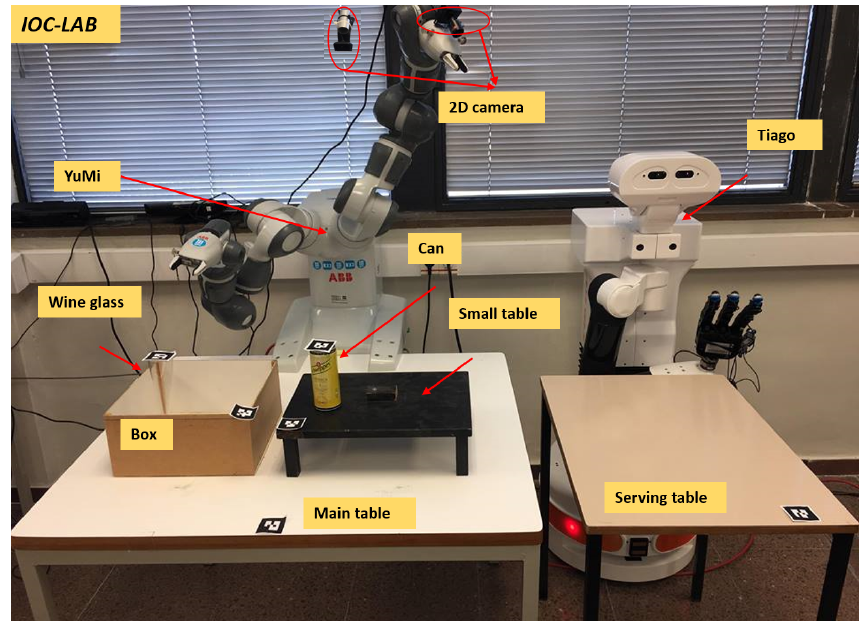
Figure 1. A motivation example of a two-robot table-top manipulation task at the